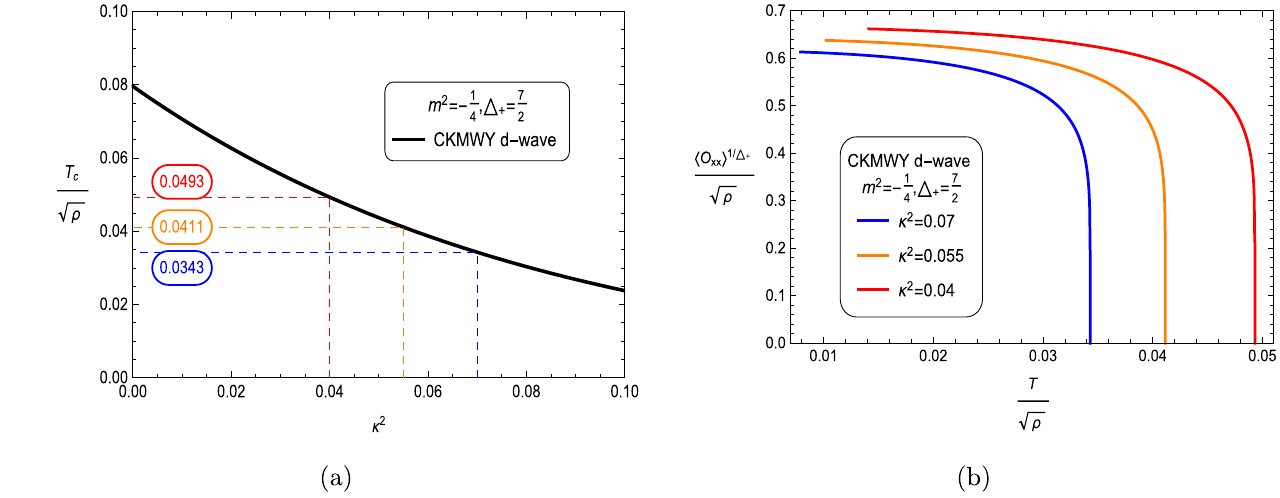
Fig. 1 The left figure depicts the change of critical temperature with backreaction κ 2 for m 2 = − 1 / 4 in the CKMWY d-wave superconduct- ing model. The right figure is the condensate as a function of tempera- ture.Differentcolorsolidlinescorrespondtodifferentbackreactionval-